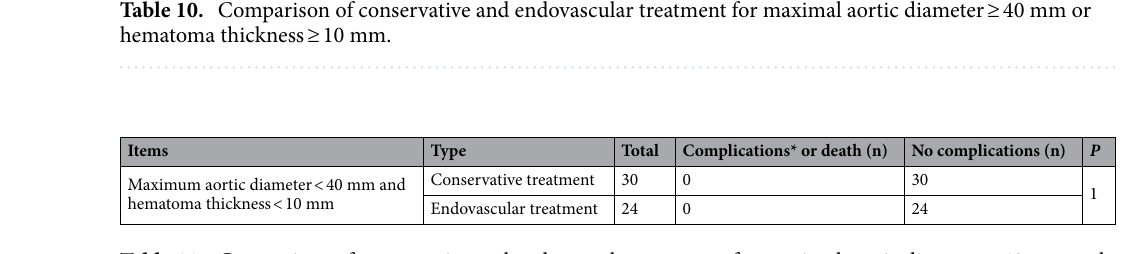
Table 11. Comparison of conservative and endovascular treatment for maximal aortic diameter < 40 mm and hematoma thickness < 10 mm. *Progression of aortic dissection, pseudoaneurysm, rupture, visceral arterial perfusion, lower limb